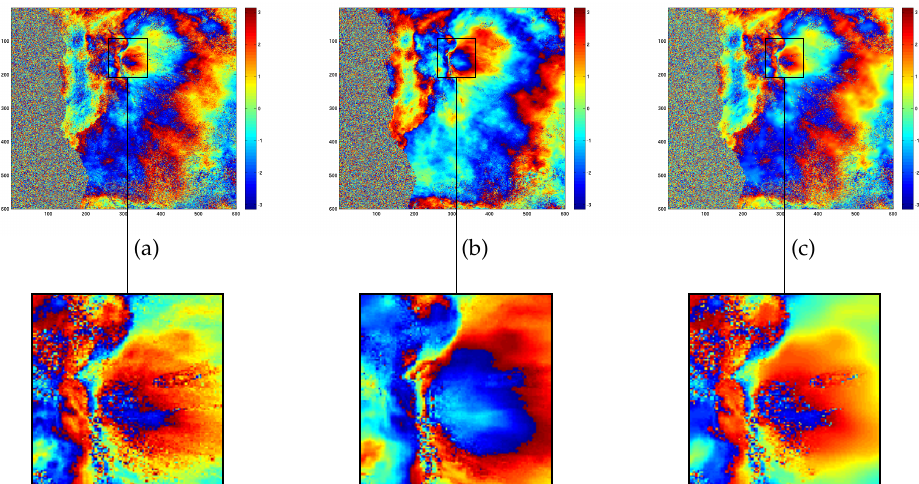
700 patch of interferogram 700 patch of × ×